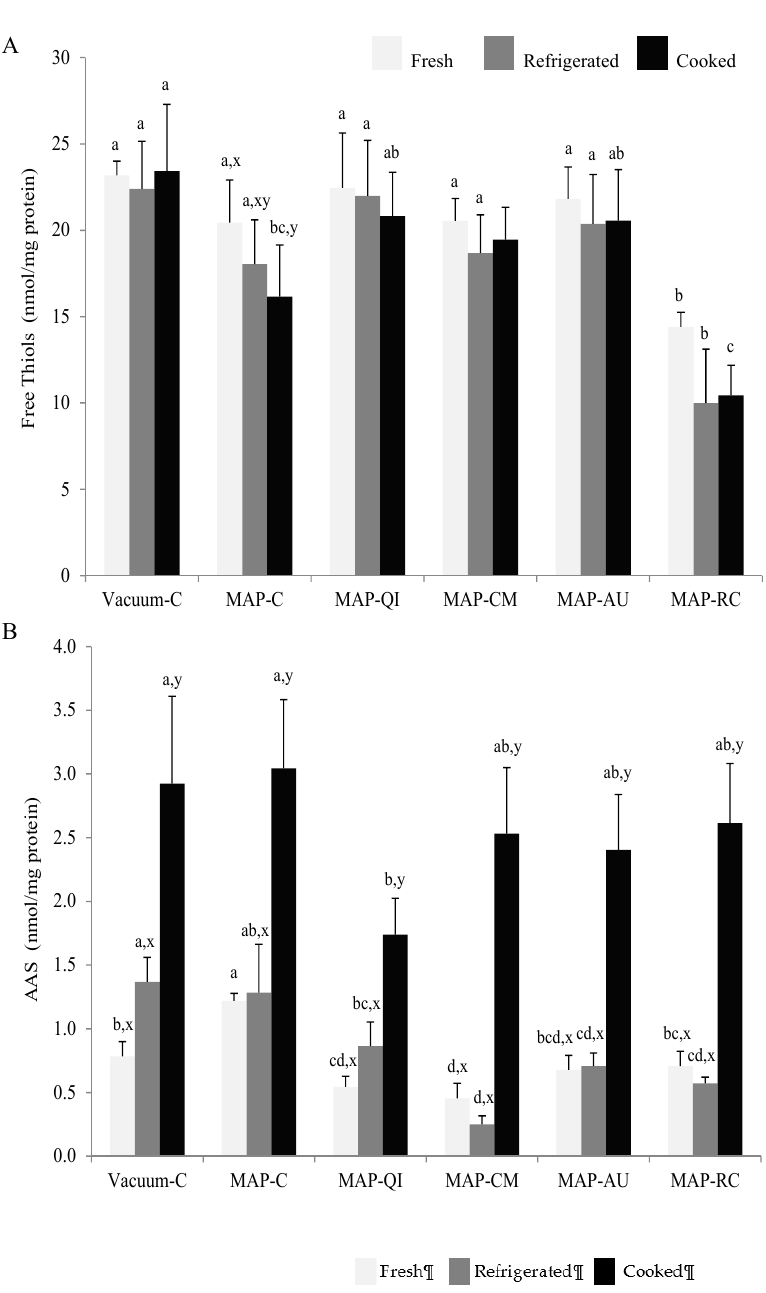
Figure 2. Concentration (nmol / mg protein) of protein thiols ( A ) protein oxidation marker, α -amino adipic semialdehyde (AAS) ( B ) (mean ± standard deviation), in fresh, refrigerated and cooked lamb cutlets. Sample description: Vacuum-C (cutlets packed in a vacuum package and no added extract), MAP-C (cutlets packed in a High-Ox-MAP and no added extract), MAP-QI (cutlets packed in High-Ox-MAP and treated with QI extract), MAP-CM (cutlets packed in a High-Ox-MAP and treated with CM extract), MAP-AU (cutlets packed in a High-Ox-MAP and treated with AU extract) and MAP-RC (cutlets packed in a High-Ox-MAP and treated with RC extract). a–d Different letters on top of bars denote significant differences between treatments within a processing stage (Fresh, refrigerated or cooked). x–z Different letters on top of bars denote significant differences between processing stages within a particular treatment.